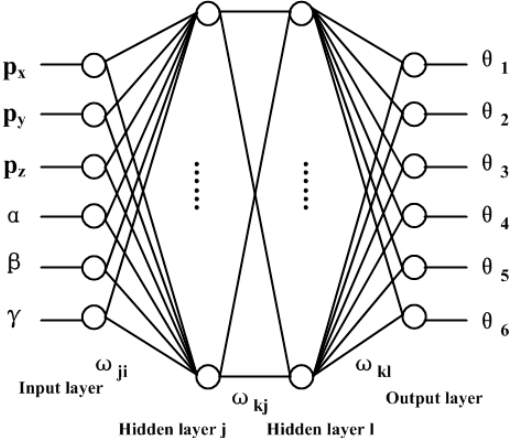
Figure 5. BP (back propagation) neural network topology structure.